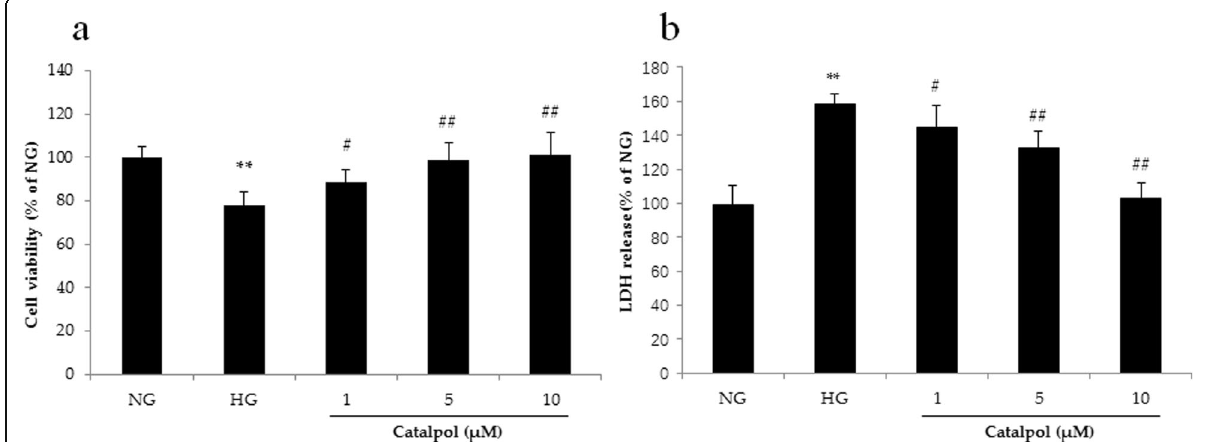
Fig. 2 The protective effect of catalpol on HG-induced podocyte injury. a Cell viability ( n = 6). b LDH release ( n = 6). Data are presented as the mean ± SD. ** p < 0.01 vs NG, # p < 0.05, ## p < 0.01 vs